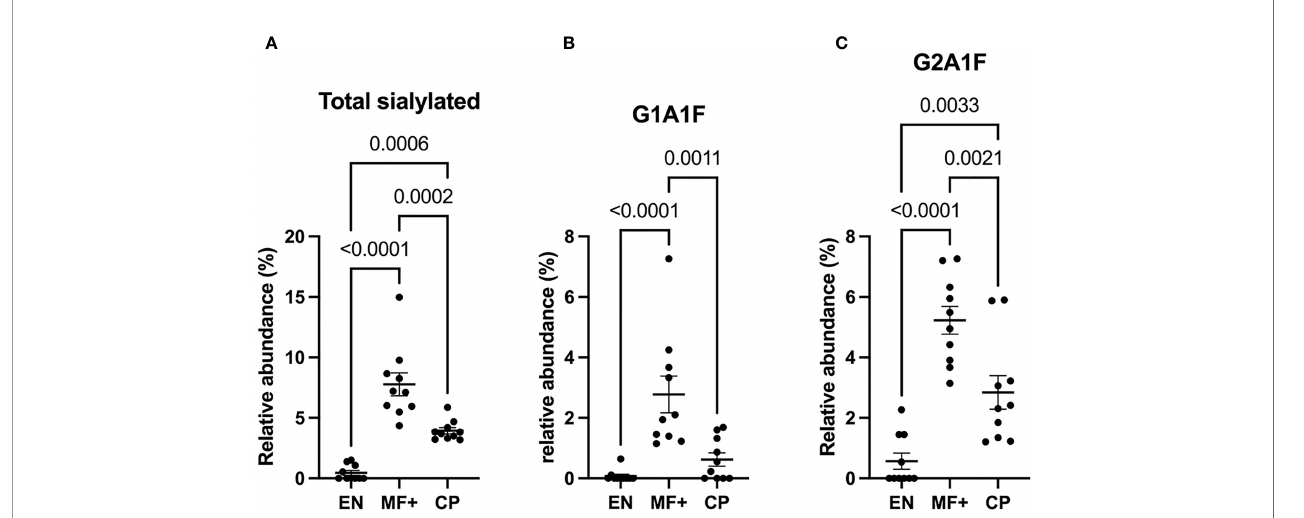
FIGURE 7 | Higher levels of IgG-sialylation are associated with asymptomatic infection during LF. Graphs represent the relative abundance of IgG-bound glycan structures with sialic acid residues in total IgG puri fi ed from EN, MF+, and CP patients (A – C) . Dots represent individual donors. Bars represent means ± SEM. Statistical analyses were performed using the Kruskal – Wallis nonparametric test with Dunn ’ s multiple comparison post-test. Signi fi cance is accepted when P <